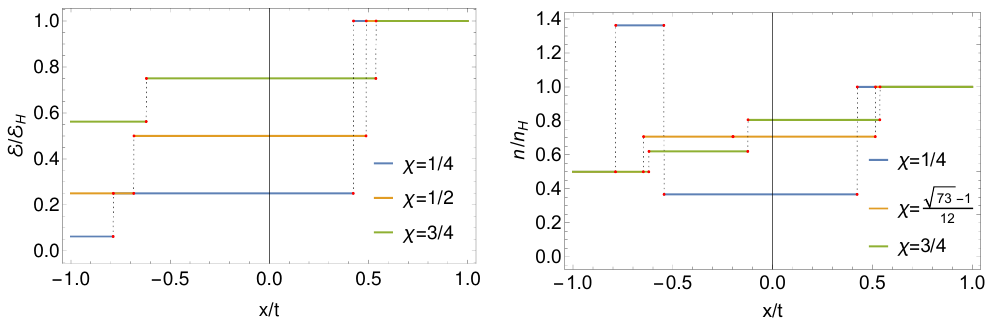
Figure 1: Energy density (left) and charge density (right) of the double shock solu- tion. The energy plot on the left shows the two heat baths and the NESS region. The charge plot displays the additional contact discontinuity that is absent for the middle value of χ